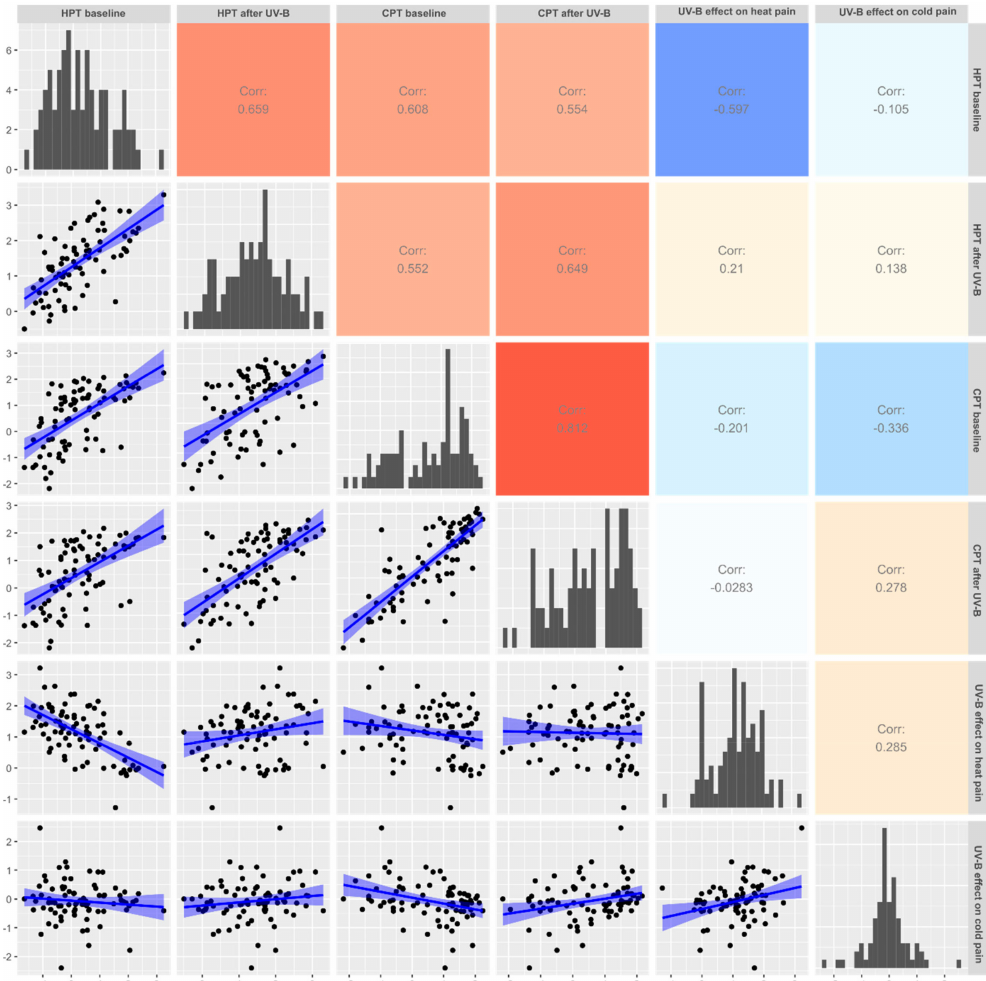
Figure 2. Correlation scatter plot matrix of the pain thresholds to heat and cold stimuli acquired under control conditions or after UV-B irradiation, and of the UV-B e ff ects calculated as the di ff erences between the corresponding thresholds with and without UV-B-induced hypersensitization. In the lower left part, single observations are shown as black dots. The lines indicate a linear fit (and confidence intervals) for visual guidance. Please note, however, that the statistics have been done using non-parametric correlations shown in the upper right part of the matrix as values of Pearson’s r . The correlation strength is also color coded from red, indicating a high positive correlation, via grey / white, indicating no correlation, to blue, indicating a strong negative correlation. The diagonal shows the data distribution as histograms. The figure has created using the R software package (v. 3.6.2 for Linux; http: // CRAN.R-project.org / [25]) and the libraries “ggplot2” (https: // cran.r-project.org / package = ggplot2 [26]) and “GGally” (https: // cran.r-project.org / package = GGally [27]). Repeated incremental clipping for error reduction (RIPPER) was able to assign the subjects